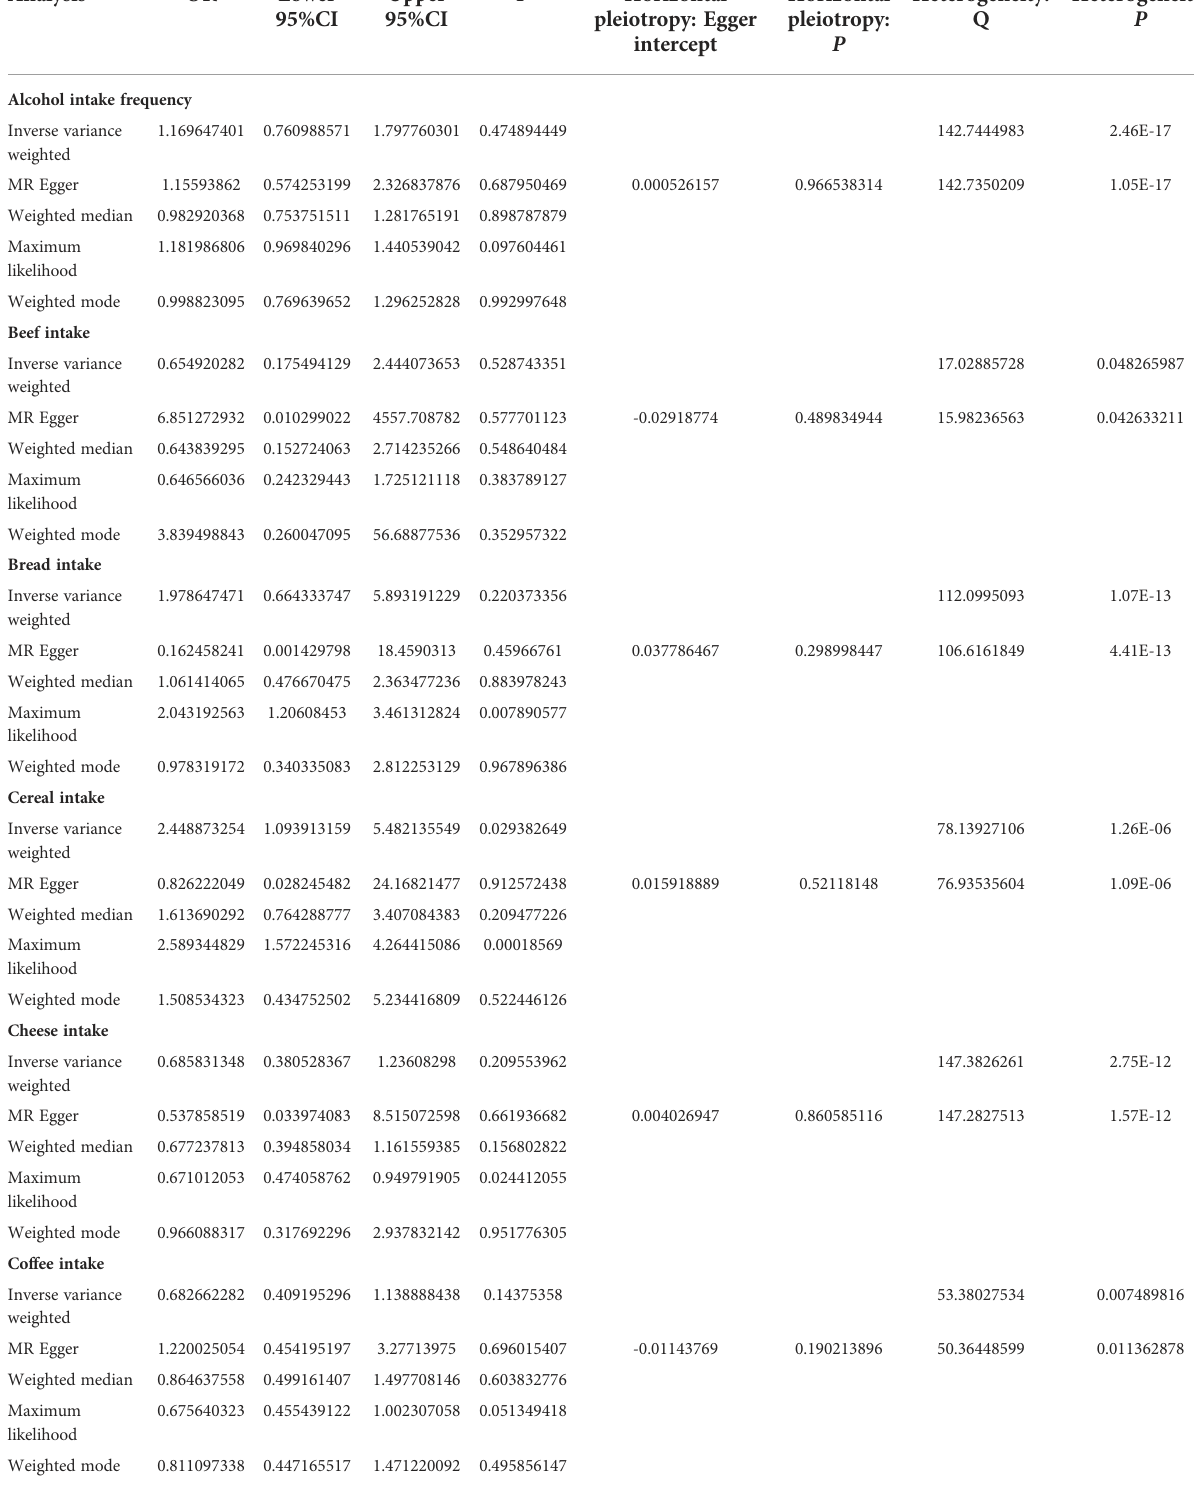
TABLE 3 Results of the MR study testing causal association between risk factors and